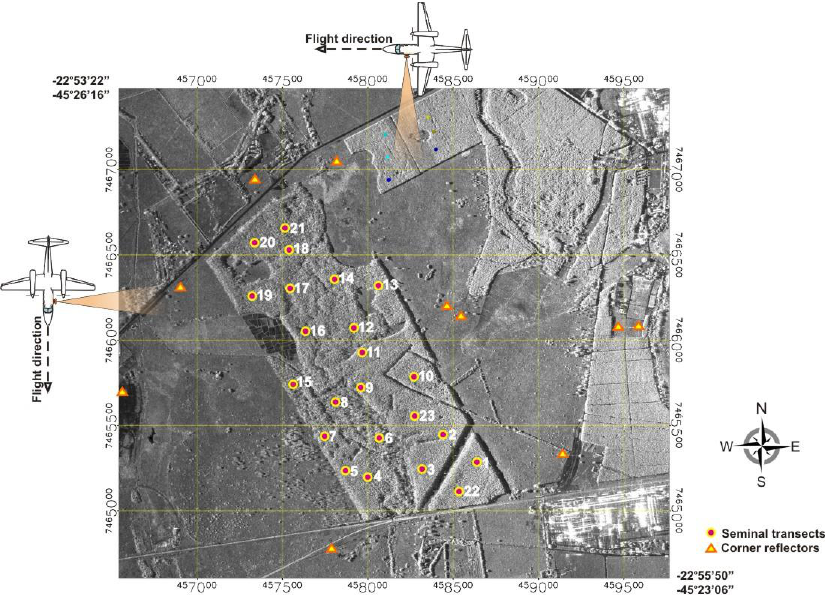
Figure 1. Study area and the inventory